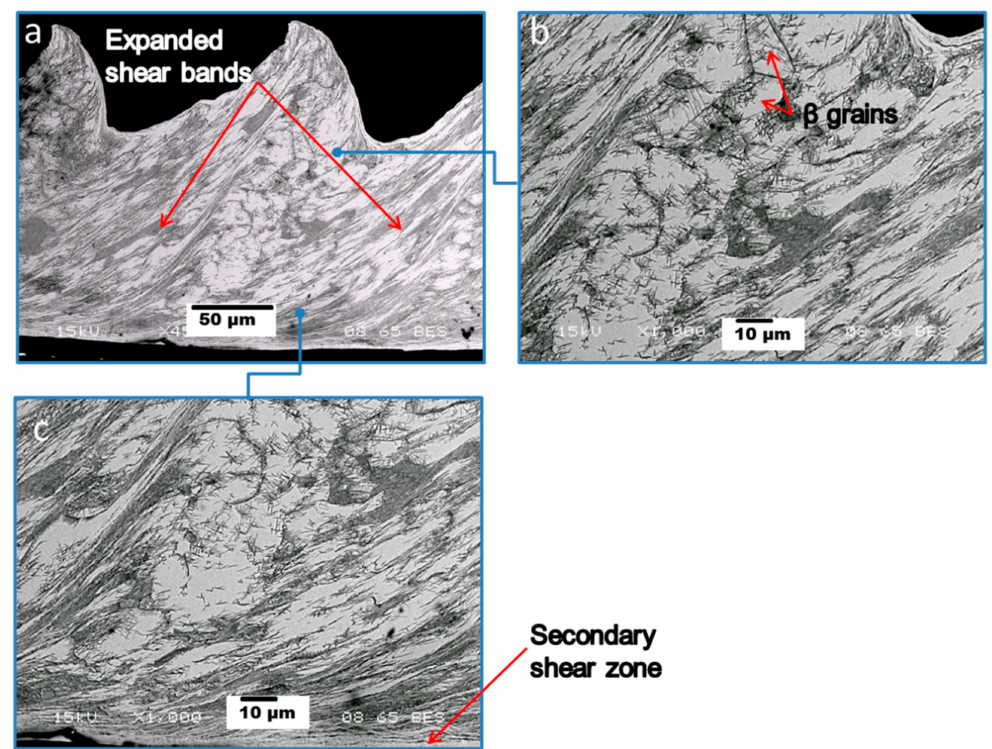
Figure 2. SEM of machining chip microstructure for surface cutting speed around 90 m/min: ( a ) Low magnification image of segmented chip morphology. ( b ) Undeformed chip region with original β grain structure of the workpiece material with in-tact β grains highlighted. ( c ) Higher magnification image of the secondary shear zone which adjoins the tool rake face during